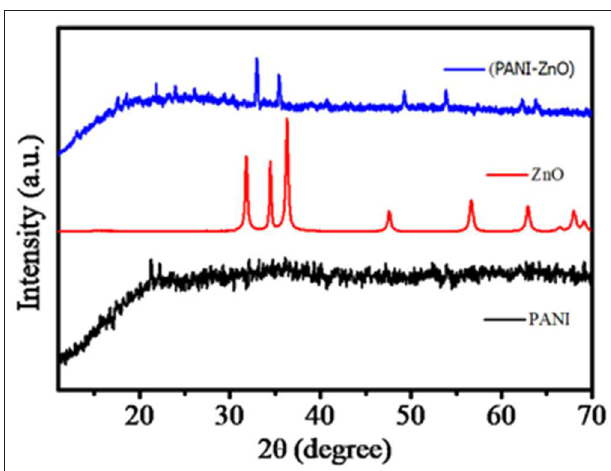
FIGURE 2 | XRD pattern of PANI, ZnO, and PANI-ZnO film.